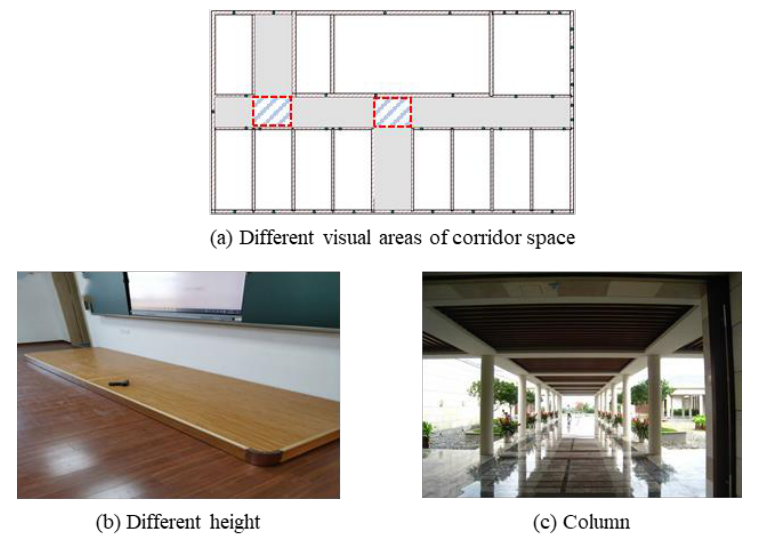
Figure 4. Spatial virtual segmentation.